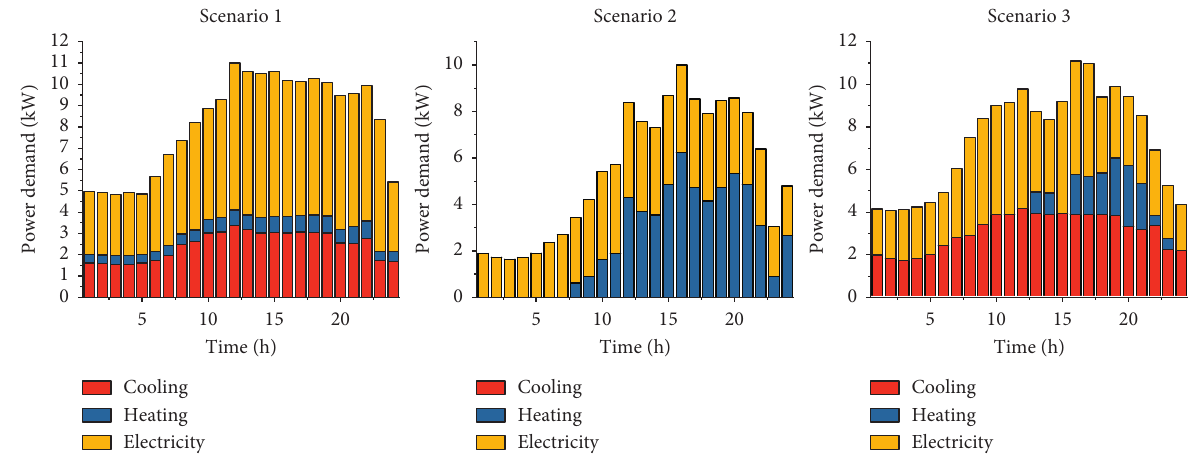
Figure 8: System energy supply information of scenarios 1–3 (designed for summer load).